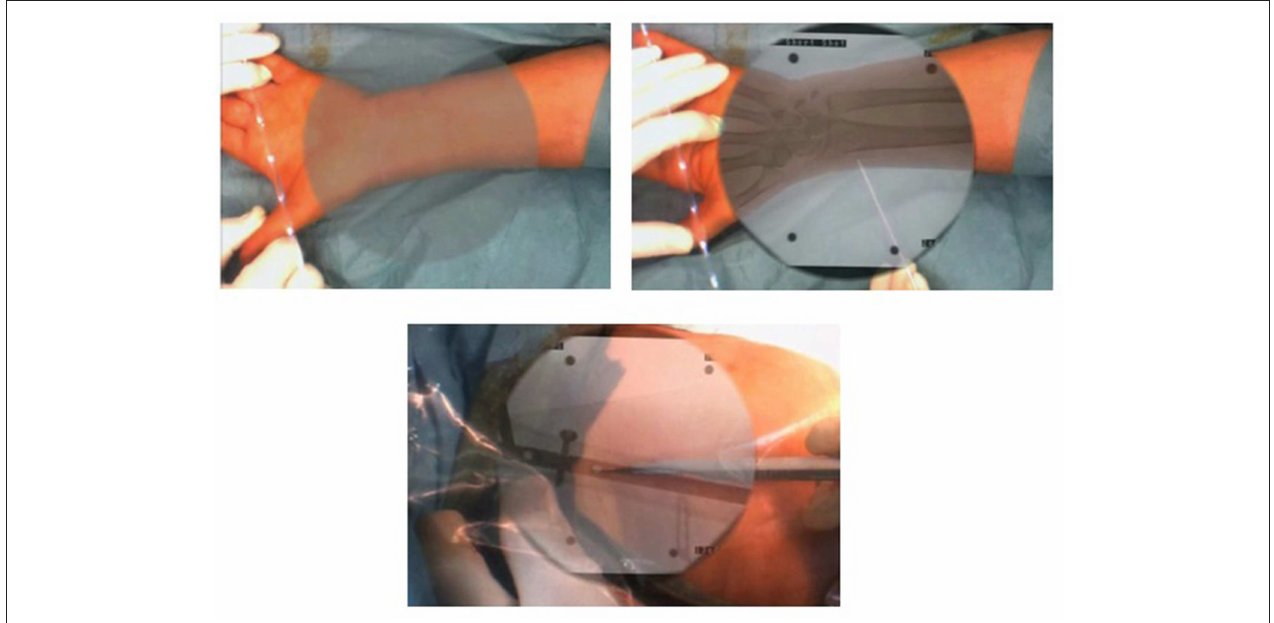
FIGURE 3 | Examples of intraoperative image in wrist surgery and distal locking intramedullary nailing (Photos courtesy of Prof. Pascal Fallavolitta, Ottava, Canada). spine, constructed via a computed tomography of a real